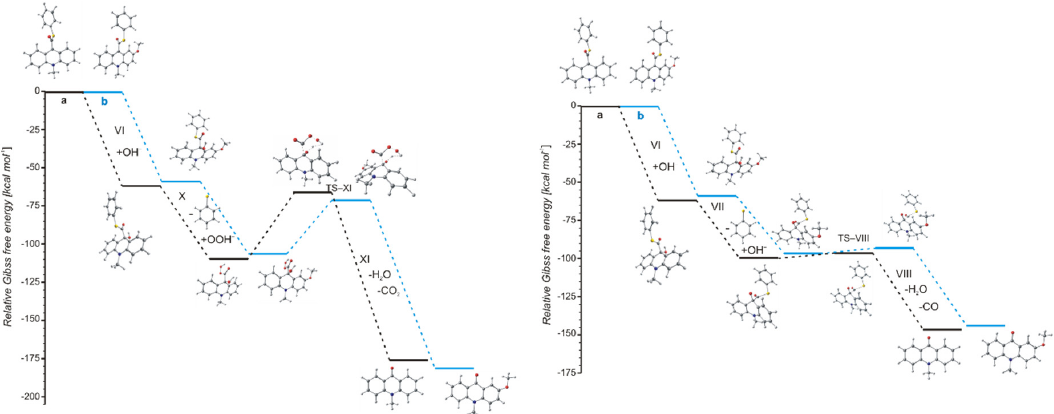
Figure 3. Relative Gibbs free energies of the reaction steps of two possibilities of non-CL pathways of acridinium thioesters: ( a , black) unsubstituted and ( b , blue) substituted in the acridine moiety.